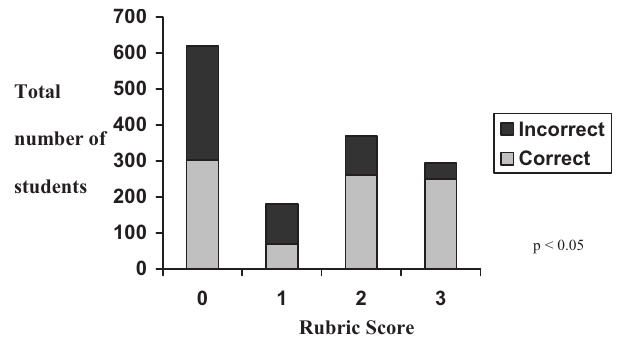
FIG. 3. Chart showing total percentages of solutions